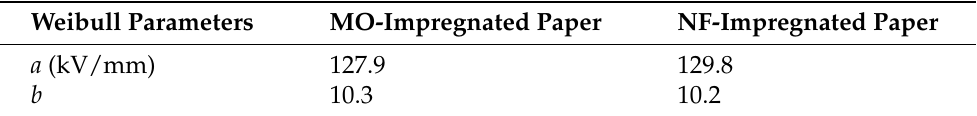
Table 7. Weibull parameters for the impulse dielectric strength of MO-impregnated and NF- impregnated paper.